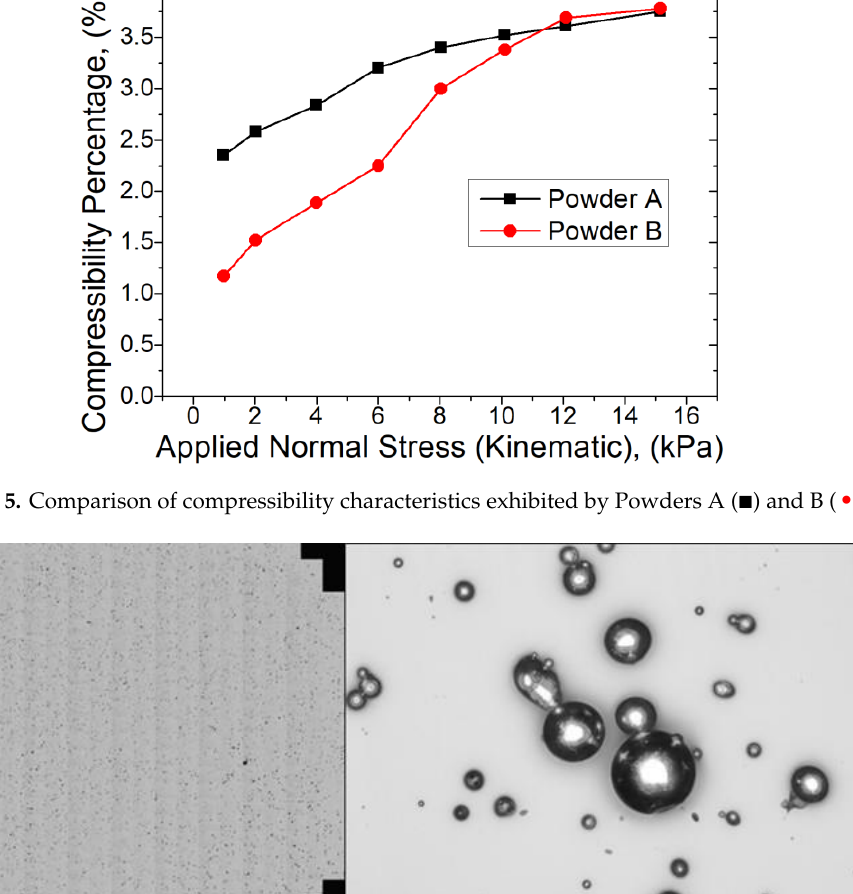
Table 2. Summary of particle size data for both powder A and